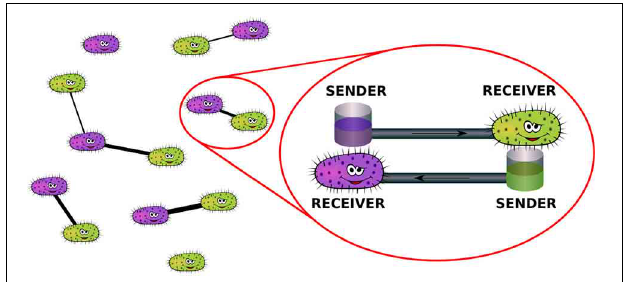
FIGURE 2 | Mechanism of network formation in the population of bacteria: couples of individuals may decide to reciprocally share a certain amount of energy in order to be able to resist environmental